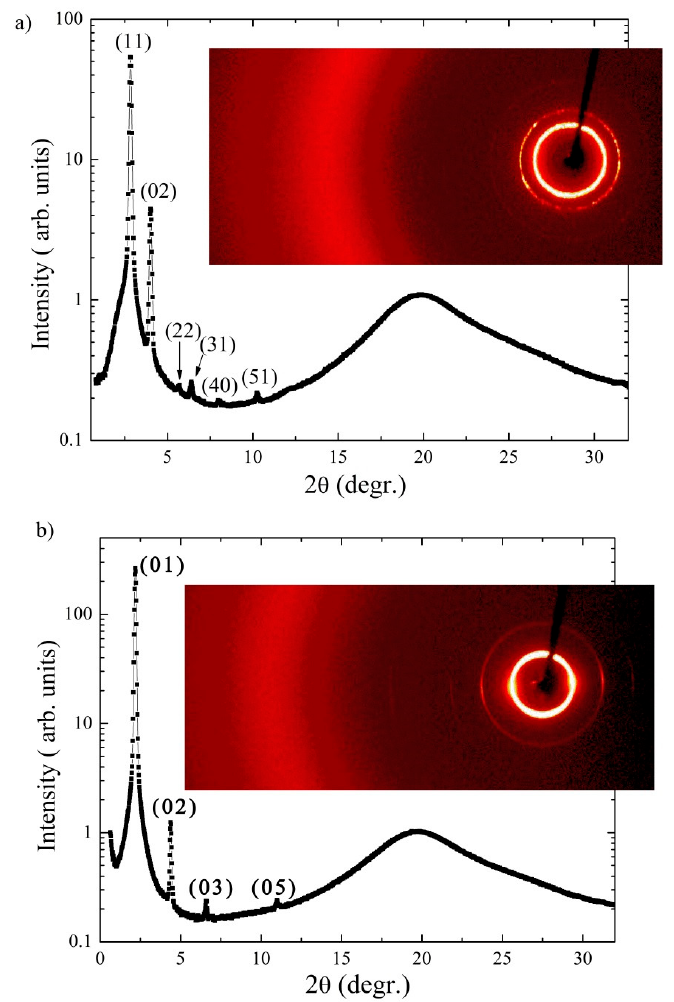
Figure 8. X-ray intensity profile with respect to the scattering angle ( a ) for Ib in the B 1 phase at T = 100 °C, and ( b ) for Ic at T = 95 °C. Miller indexes are placed above the corresponding peaks.